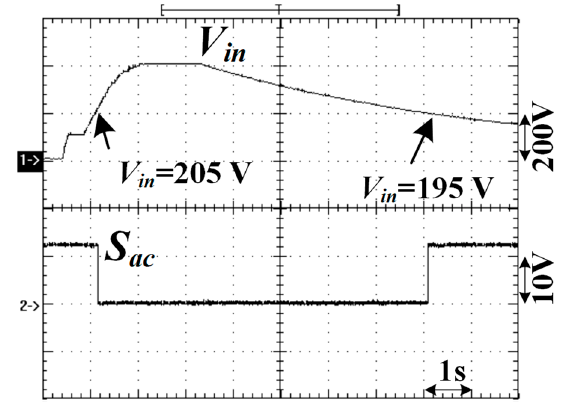
Figure 11. The experimental waveforms of the input voltage V in and PWM signal of S ac .